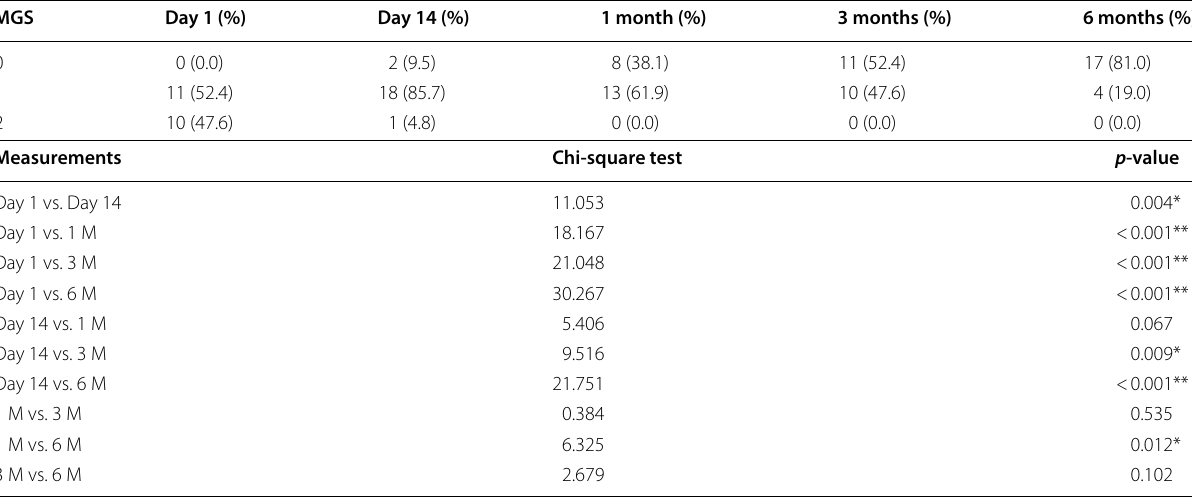
Table 7 A MGS values for patient with a favorable neurological outcome ( n MGS values for patient with a favorable neurological outcome ( n